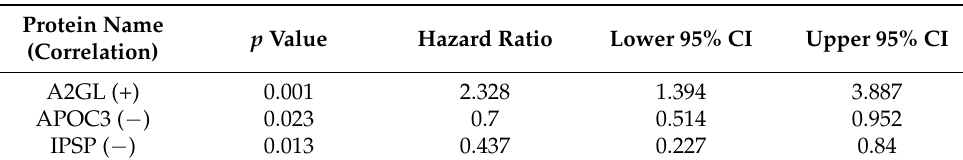
Table 1. Proteins showing a significant ( p < 0.05) Cox regression against overall survival along with hazard ratios and confidence intervals (CI).